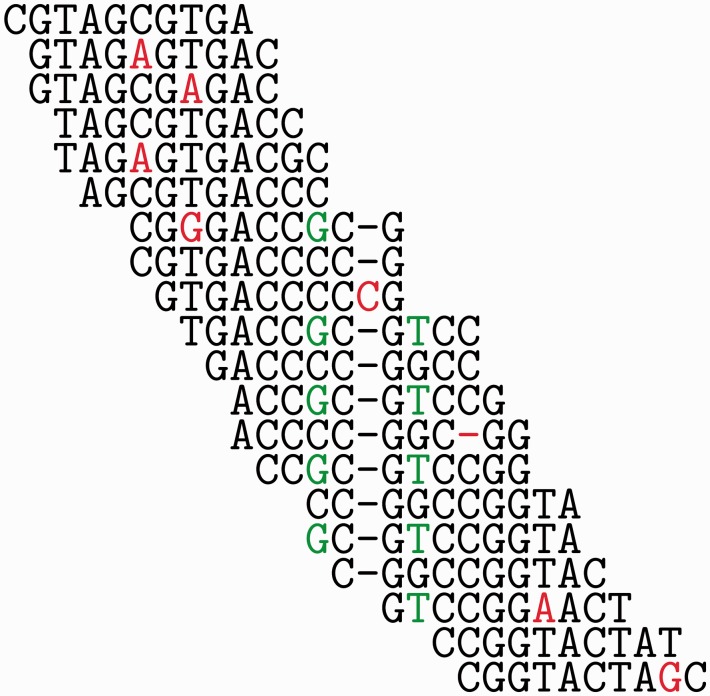
Example of a MSA of a read set, demonstrating consistent mismatches (green nucleotides) in comparison to isolated or low-frequency mismatches and indels (red nucleotides and dashes). The consistency of mismatches can be tested through their linkage within reads (four in this example) and are called DNPs in the first tool that used such information, MisEd [86, 87]. However, genuine polymorphisms can only be told from sequencing errors if multiple of the linked variant sites are within the range covered by the average read (pair). A colour version of this figure is available at BIB online: http://bib.oxfordjournals.org.